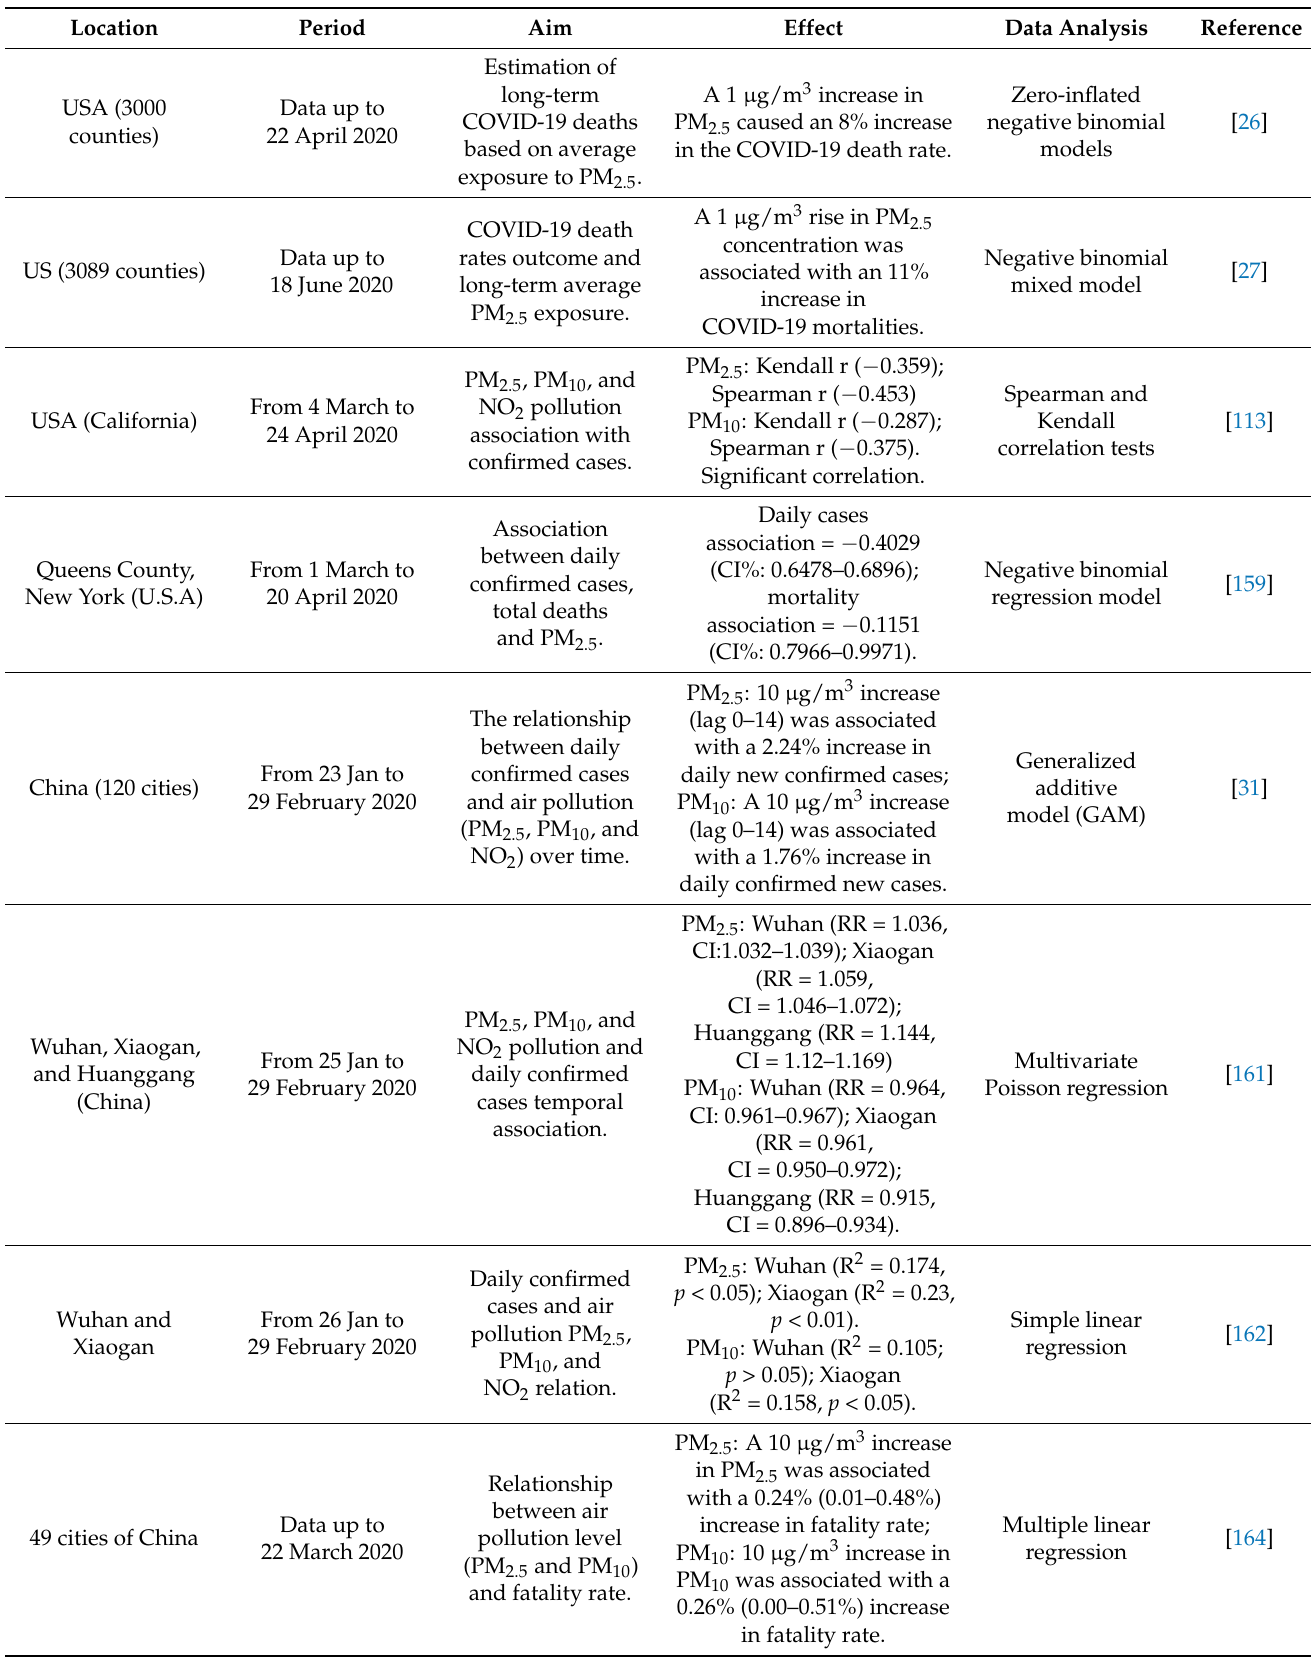
Table 3. PM pollution and COVID-19